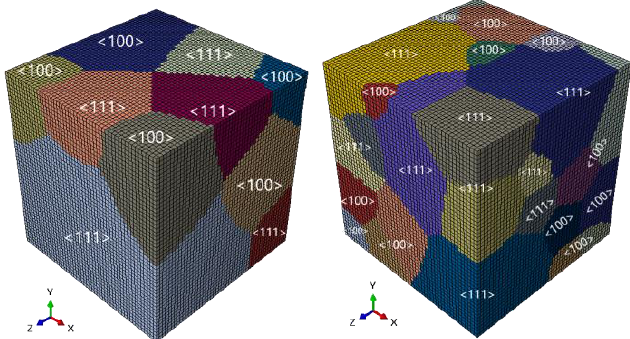
Figure 2. Two synthetic polycrystalline aggregates of 11 and 44 grains generated with the code DREAM.3D. The stiffest direction <111> and the least stiff direction <100> randomly assigned on each grain are also displayed.